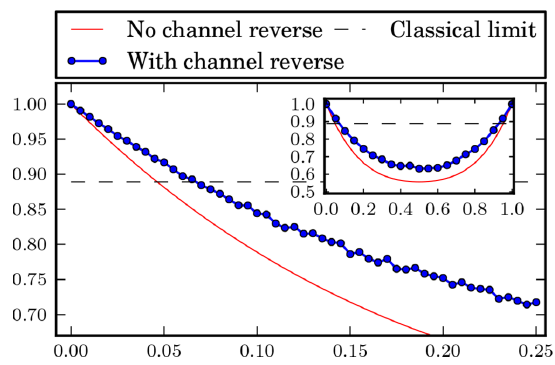
Figure 1. Phase flip channel. Probability of winning the pseudo- telepathy game with and without the use of our approach as a function of the noise parameter a for the phase flip channel. The inset shows the probability of winning for a M [0; 1].